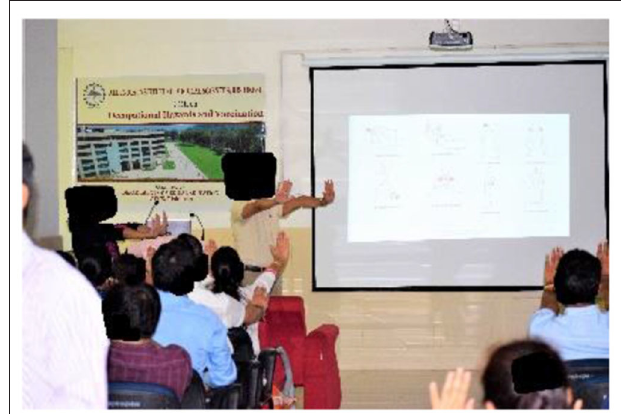
FIGURE 1 | Participants performing exercise while being demonstrated by an instructor during delivery of ergonomic training